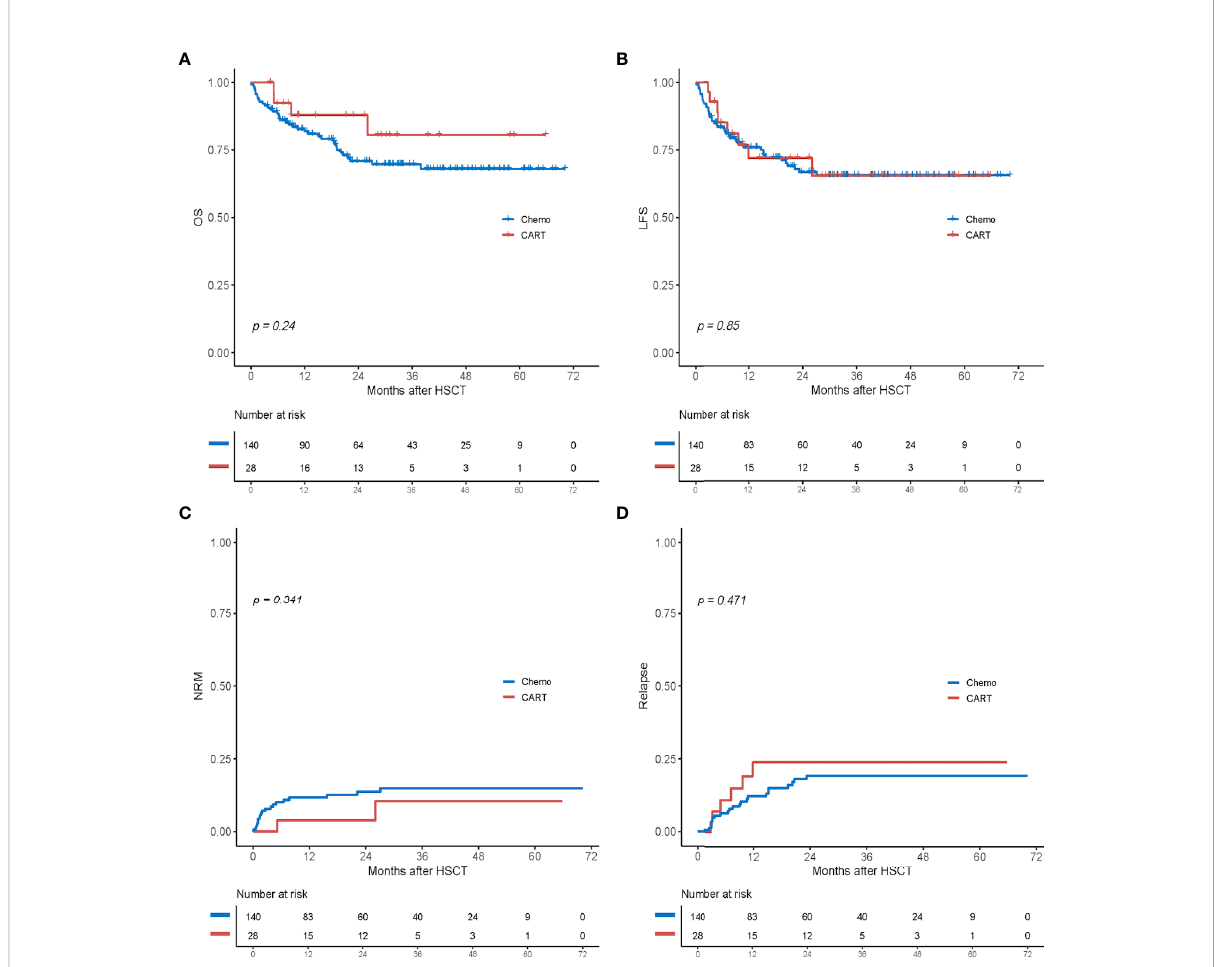
FIGURE 2 Outcomes after haploidentical HSCT between the chemotherapy group (chemo) and the CAR-T group. (A) OS. (B) LFS. (C) Cumulative incidence of non-relapse mortality (NRM). (D) Cumulative incidence of relapse. HSCT, hematopoietic stem cell transplantation; CAR-T, chimeric antigen receptor T cell; OS, overall survival; LFS, leukemia-free